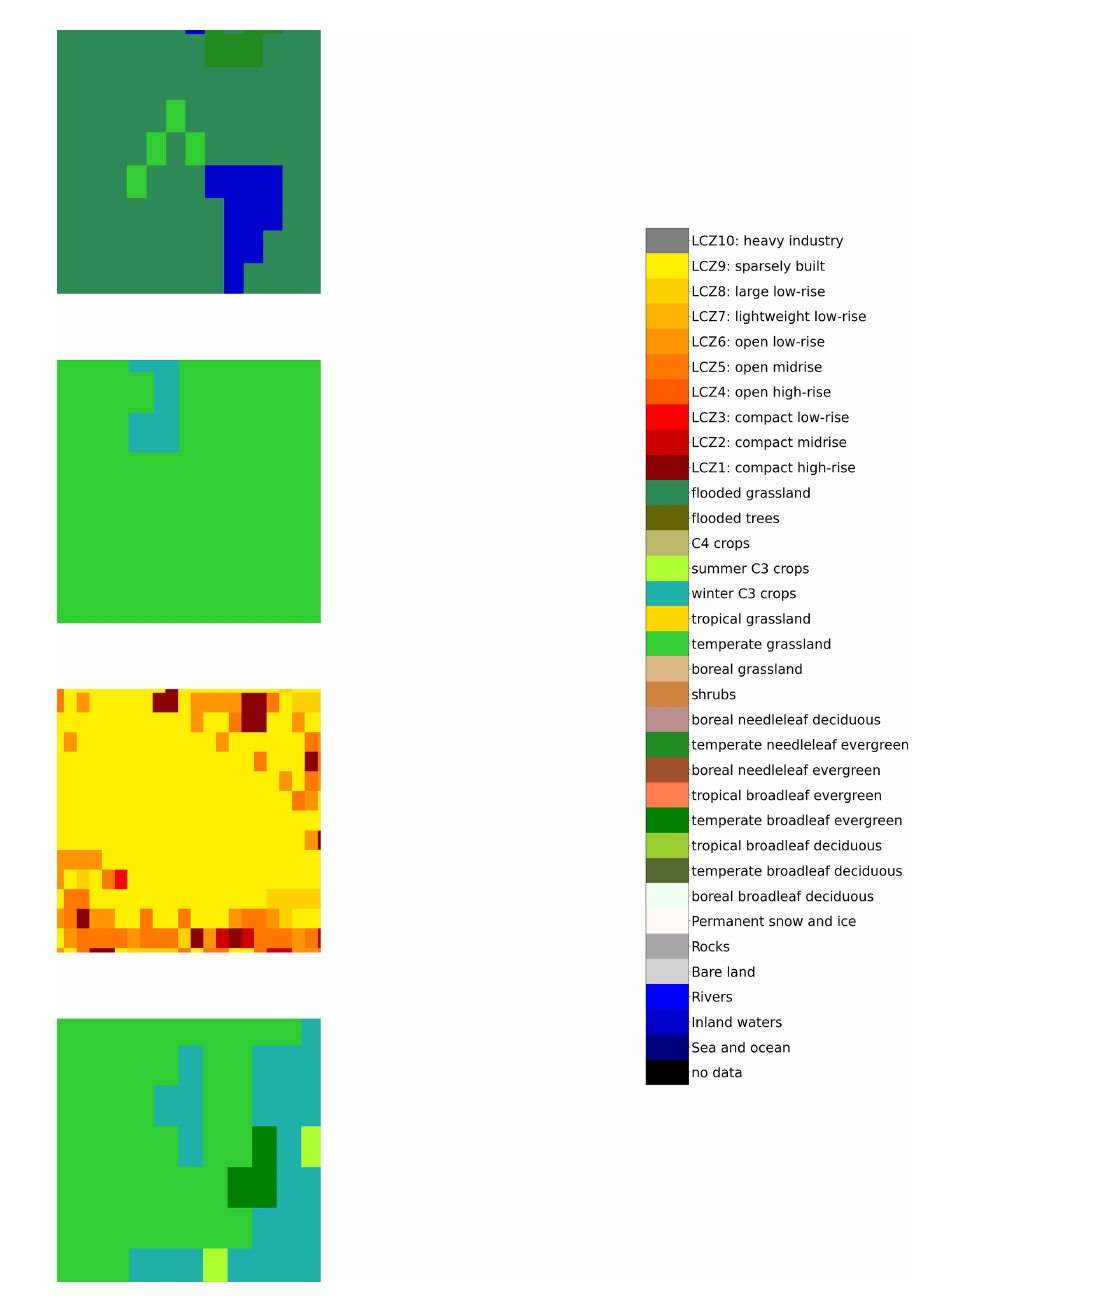
Figure C1. ECO-SG segments with full ECO-SG labelling for the satellite areas displayed in Figs. 7 and